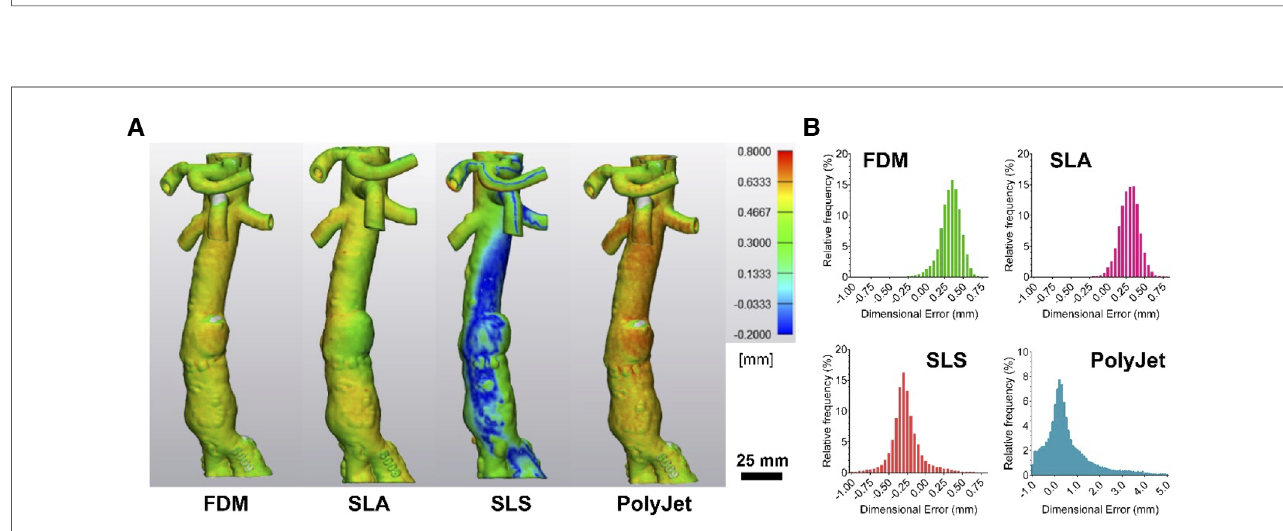
FIGURE 5 Surface congruency analysis of 3D-printed models compared to digital model. ( A ) Representative images of surface congruency analysis of FDM, SLA, SLS, and PolyJet printed anatomical models and ( B ) histograms demonstrating data distribution.